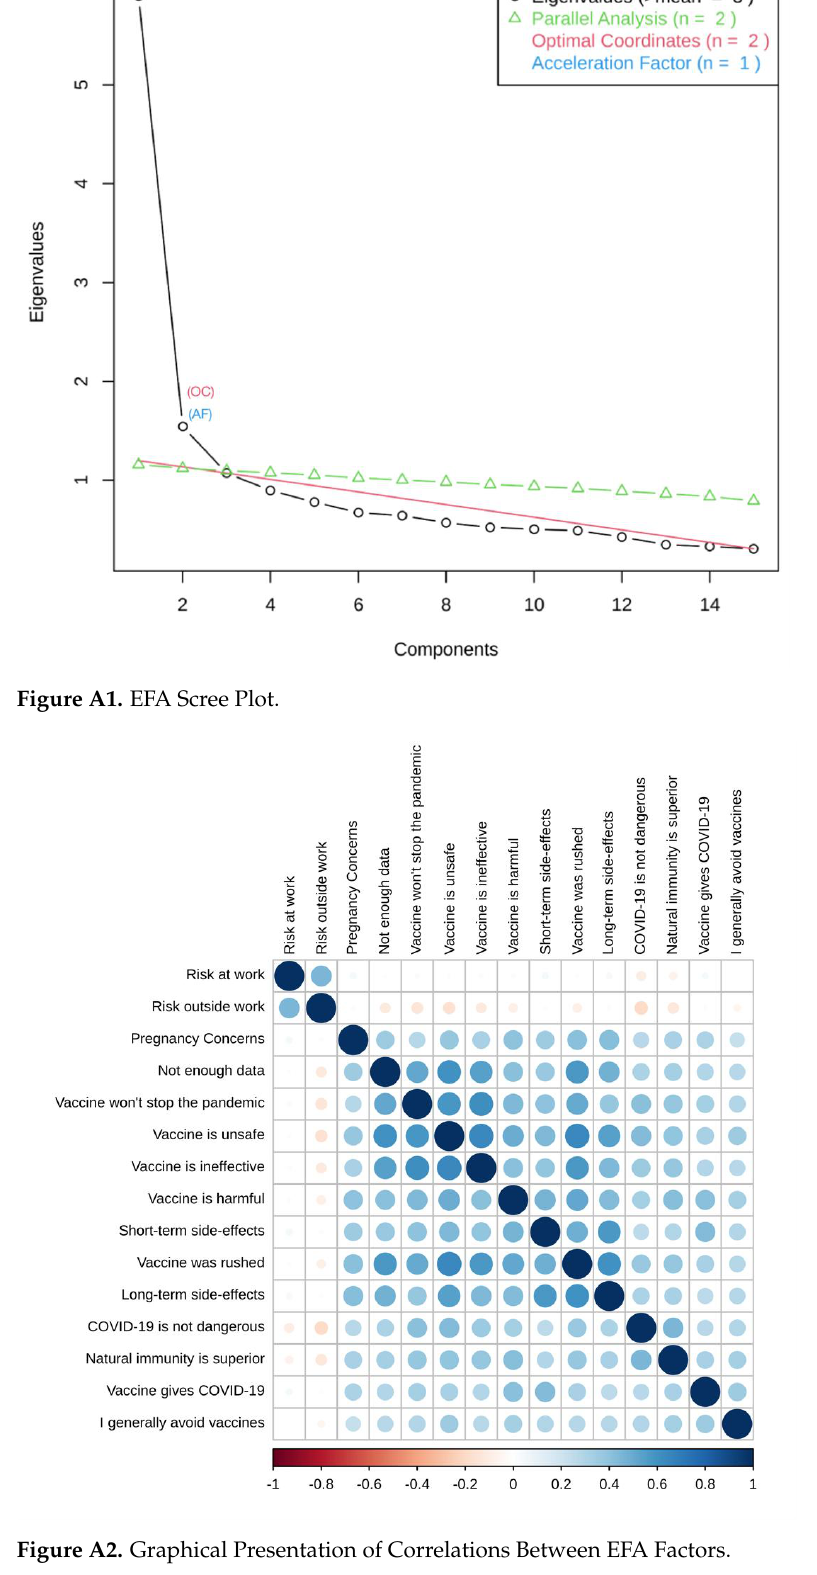
Figure A2. Graphical Presentation of Correlations Between EFA